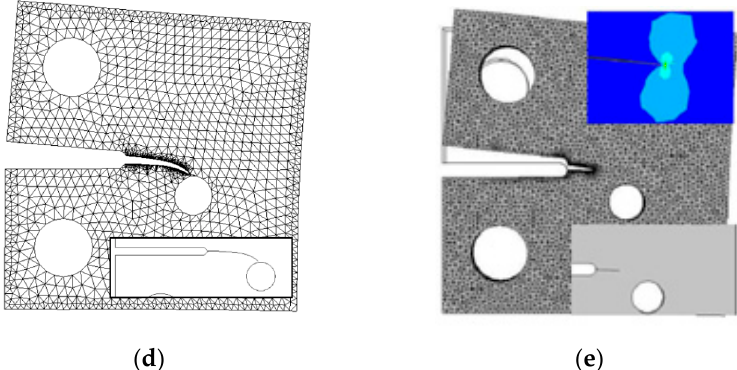
Figure 10. Predicted crack growth path for G4 specimen ( a ) ANSYS Workbench, ( b ) FRANC2D/L and ( c ) Experimental [32], ( d ) numerical [33], ( e ) FRANC3D [32].